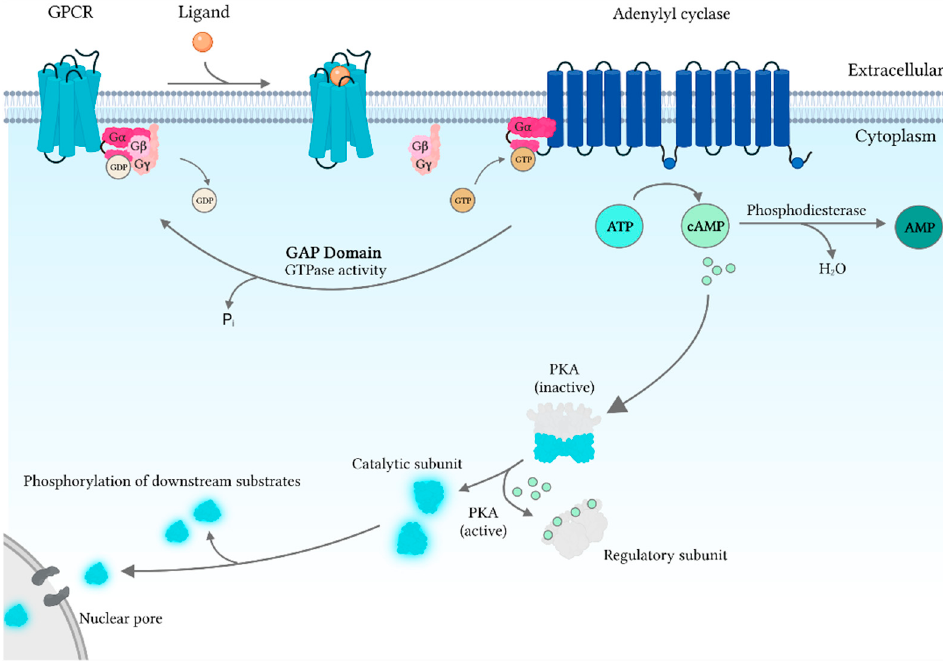
Figure 2. Schematic representation of cAMP and PKA signaling pathway in S. cerevisiae . Activation of the G-protein-coupled receptor (GPCR) by the ligand leads to the activation of adenylyl cyclase, which in turn triggers GTPase-activating proteins (GAPs) with GTP hydrolysis activity to stimulate formation of the inactive, GDP-bound protein and the release of free phosphate (Pi). Additionally, adenylyl cyclase synthesizes cAMP from ATP. When cAMP binds to the regulatory subunits of the inactive PKA, the catalytic subunits will be released and phosphorylate downstream substrates in the cytosol or translocate into the nucleus.